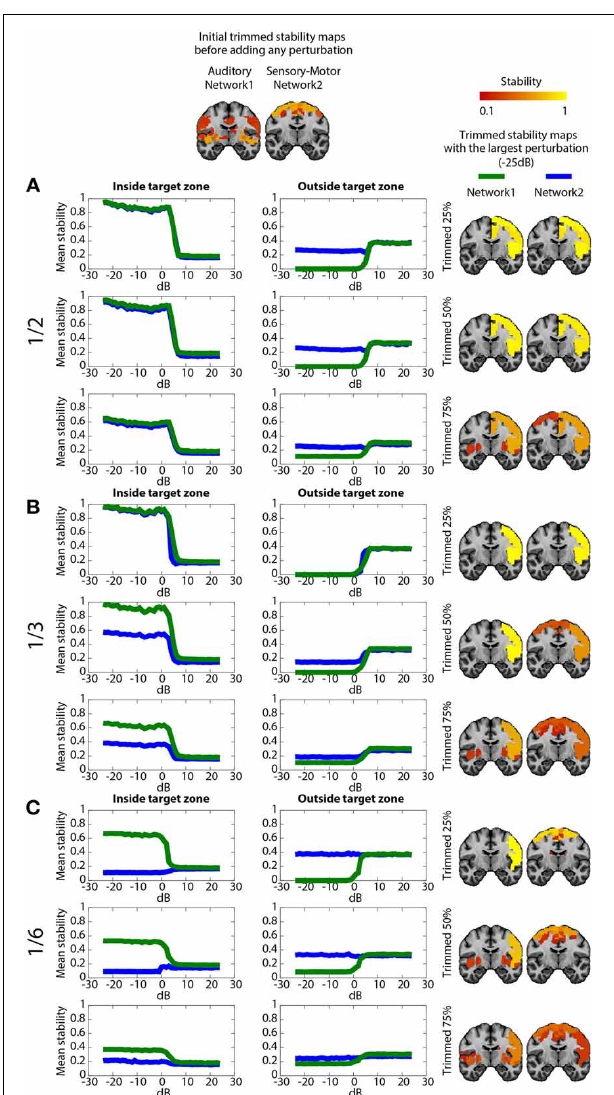
FIGURE 5 | Evaluation of DANI usingsimulated data. The first line shows the initial trimmed stability maps T n obtained for the Auditory network (network 1) and the Sensory-Motor network (network 2) before adding any (left column) perturbution. Graphs present the average stability inside I n 0 (middlecolumn)theperturbed areaasafunction of SNR dB values outside O n 0 ranging from − 25dB to + 25dB, for both the Auditory (green) and the Sensory-Motor (blue) networks. The right column shows the resulting trimmed stability maps T n obtained when adding the largest perturbation at SNR dB = − 25 dB . (A) perturbation zone involving 1/2 of both Auditory and Sensory-Motor networks, (B) perturbation zone involving 1/3rd of both Auditory and Sensory-Motor networks, (C) perturbation zone involving 1/6th of both Auditory and Sensory-Motor networks. In each case, results obtained when varying the core size parameter μ at 25, 50, and 75% are presented.